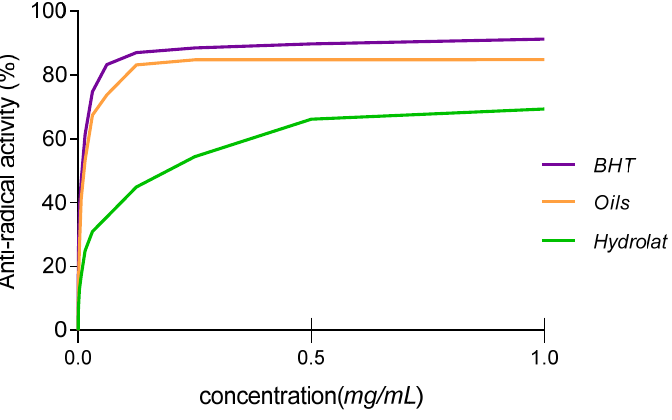
Figure 2. Anti-free radical activity of essential oil and hydrolat from W. frutescens .